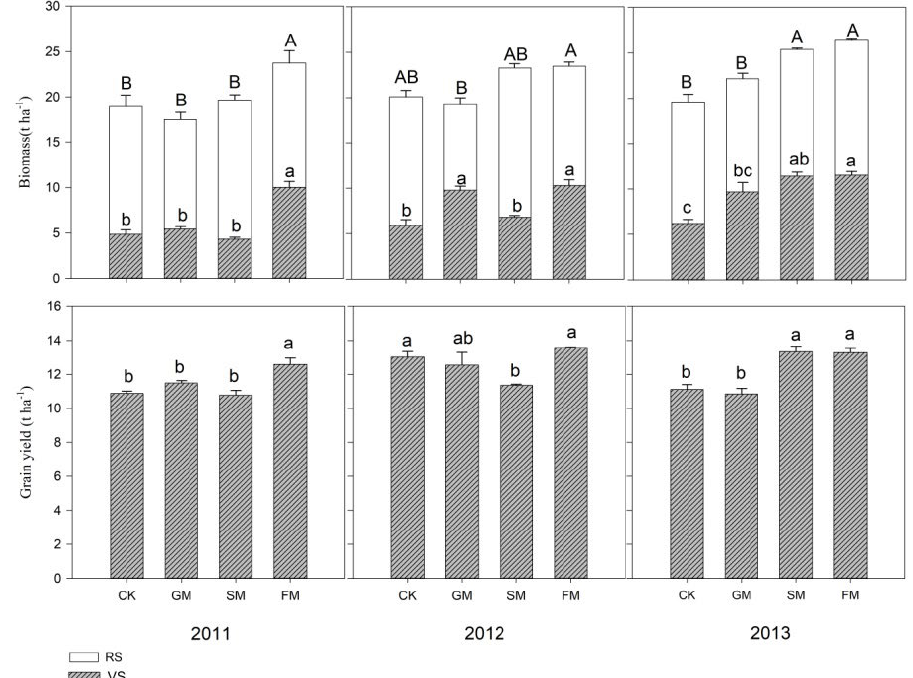
Figure 8. The aboveground biomass in the vegetative stage (VS) and reproductive stage(RS), and the grain yields under different mulching treatments, in 2011, 2012, and 2013. Note: Values with superscript letters a,b,c are significantly different of the aboveground biomass in the vegetative stage (VS) and the grain yields ( p < 0.05). Values with letters A,B are significantly different of the aboveground biomass in the reproductive stage (RS).